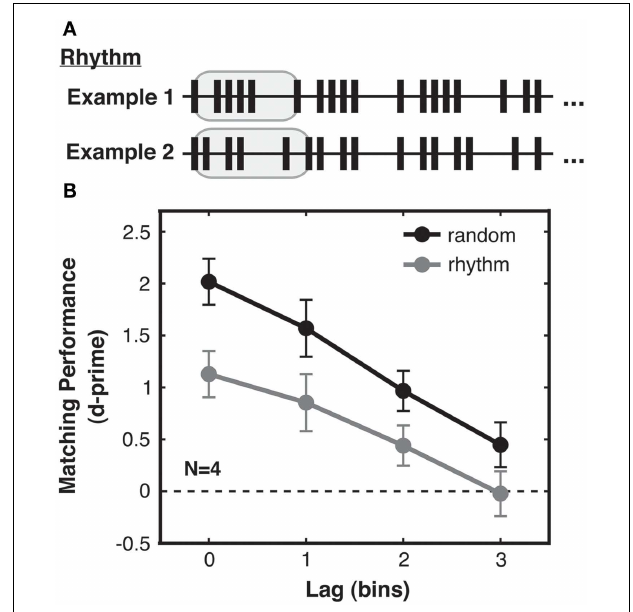
FIGURE 4 | Experiment 2: pattern complexity increases sensitivity to audio-visual correspondence. (A) Rhythmic streams were created by first generating (as in Experiment 1) a random stream “bar” lasting five ISIs (highlighted in gray), and then repeating that bar to fill the trial duration. Rhythmic streams consequently had lower temporal pattern complexity than random streams, due to the redundancy arising from bar repetition. This is quantified by differences in both first-order and second-order ISI entropy in the streams resulting from the ISI distributions of random and rhythmic streams (see main text). Examples of two rhythmic streams generated on different trials are shown (truncated for brevity). (B) Matching performance was better for random streams (black) with higher pattern complexity, compared to performance for rhythmic streams (gray). Performance for both stream types decreased in a similarly linear fashion with lag. Standard error of the difference between random and rhythmic conditions is shown for each